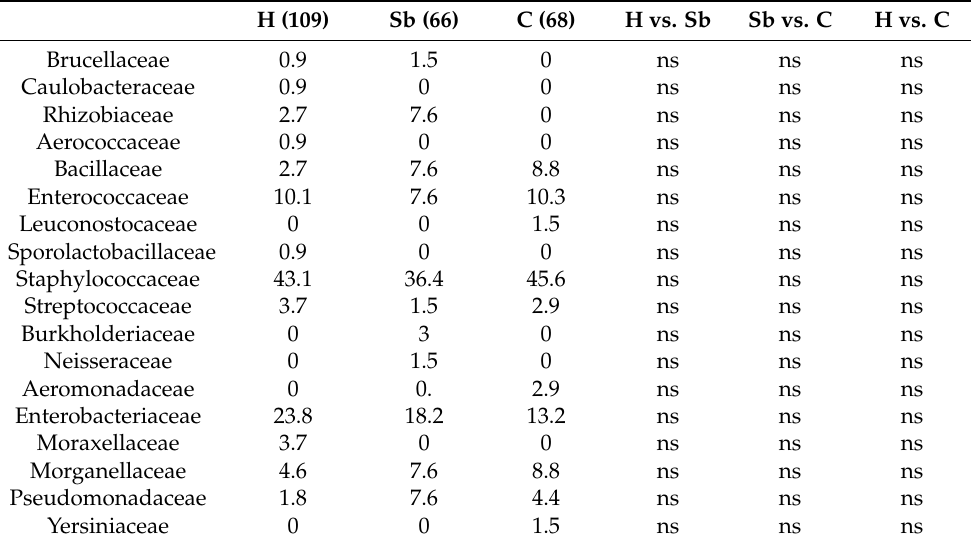
Table 2. Relative abundance (%) of cultivable bacteria at the family level according to mammary gland clinical status.